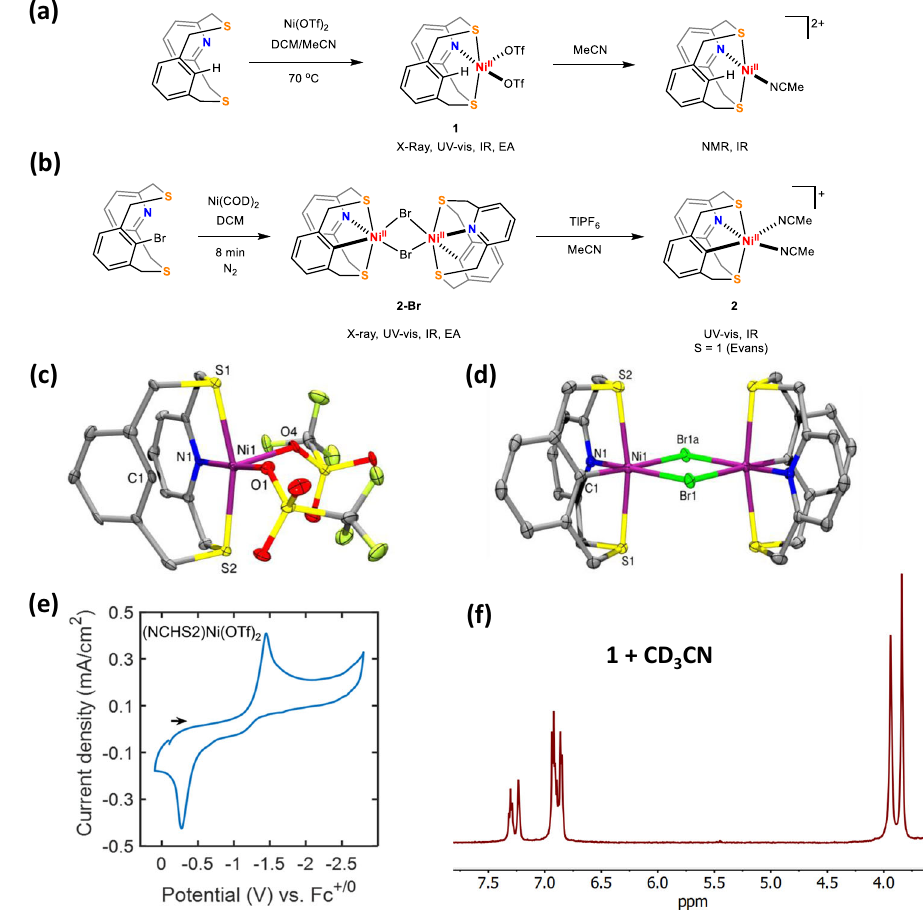
Fig.2|SynthesisandcharacterizationofNi II complexes.a SynthesisofnonC – H activated complex 1 and its proposed structure on dissolution in acetonitrile. b Synthesis of C – H activated complexes 2-Br and 2 . ORTEP representations (50% probability ellipsoids) for 1 ( c ) and 2-Br ( d ). Selected bond distances for 1 : Ni1 – N1 2.001(6), Ni1 – O4 2.039(5), Ni1 – O1 2.043(4), Ni1 – S1 2.391(2), Ni1 – S2